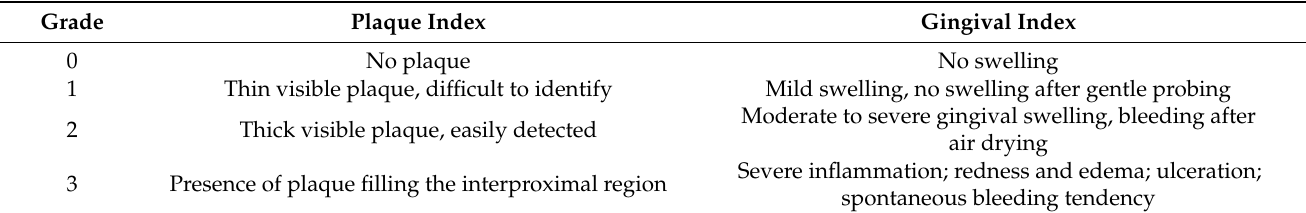
Table 3. Plaque index and gingival index (Silness and Löe).